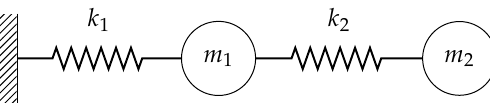
Figure 6. Schematic of two-mass